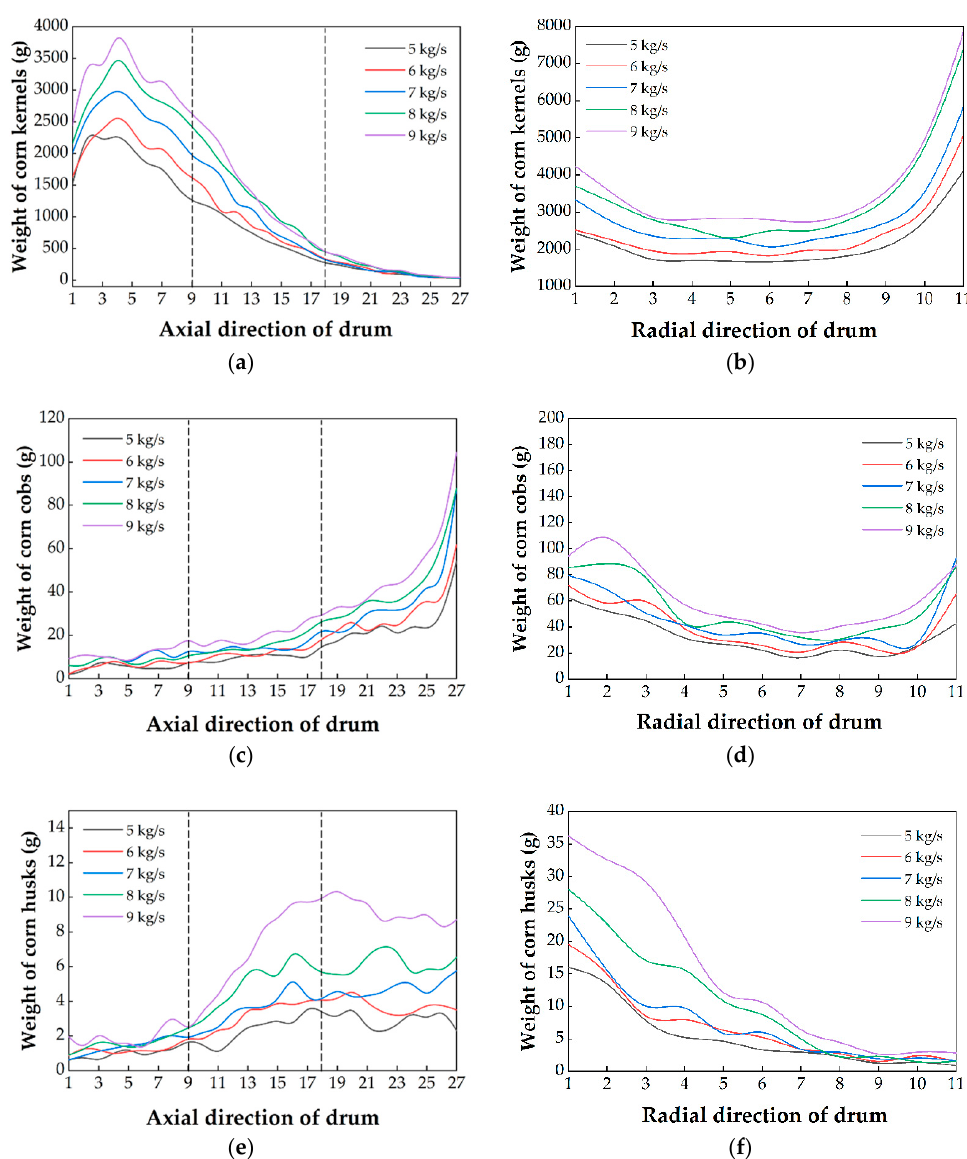
Figure 12. Weight distribution of components for different feed rates. Weight distribution curves in the axial and radial direction of ( a , b ) corn kernels; ( c , d ) corn cobs; and ( e , f ) corn husks.